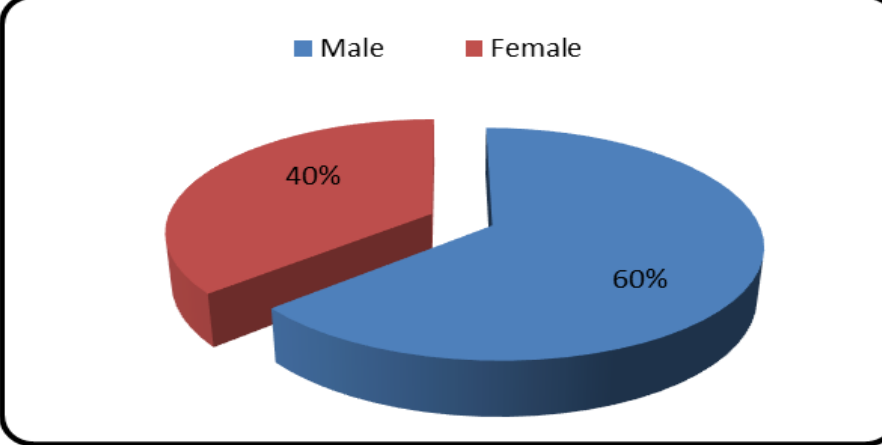
Figure 5 . Age distribution among the studied group.